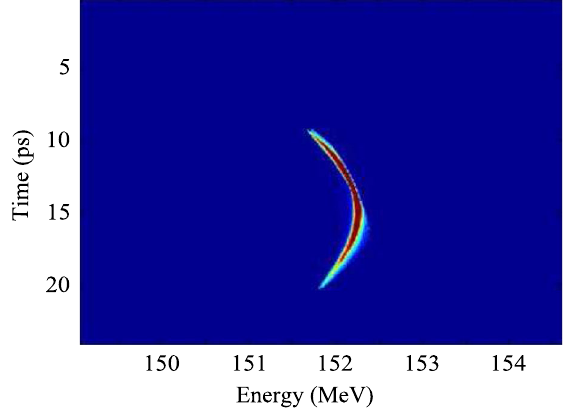
FIG. 4. Phase space of the e-beam measured with time/energy dispersion induced by rf-deflector/spectrometer dipole.